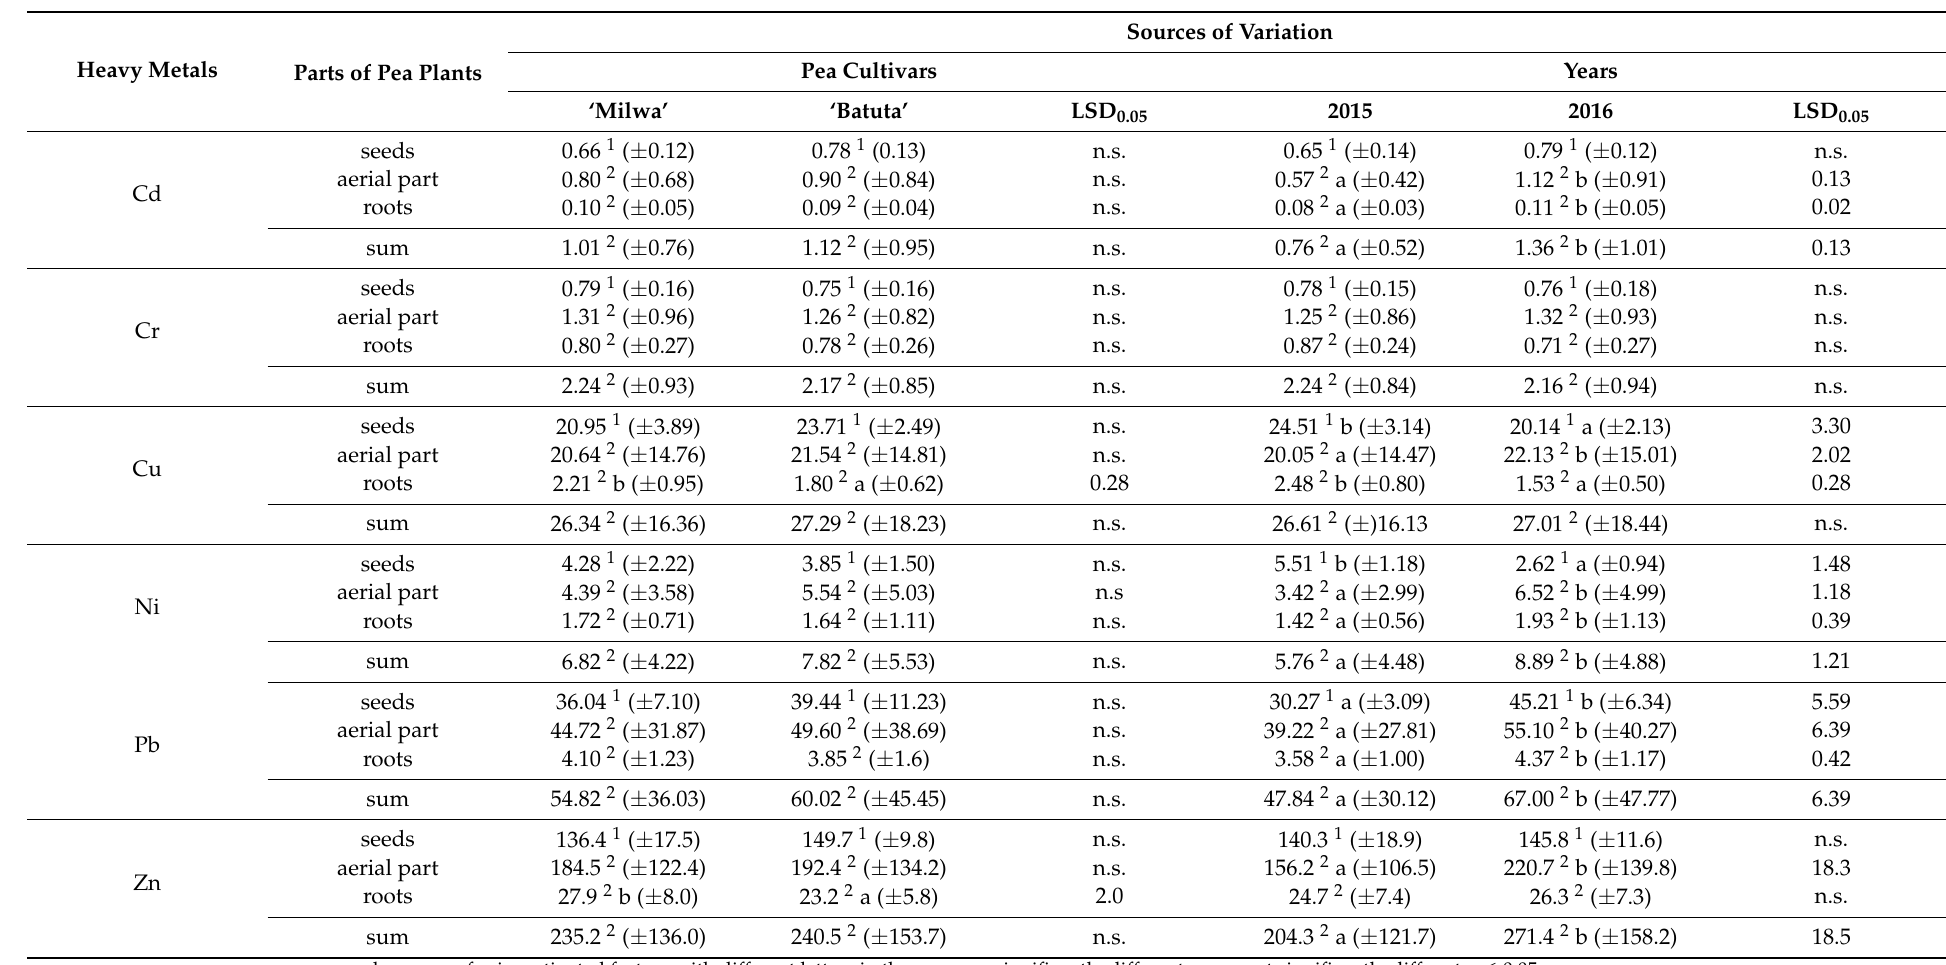
Table 6. HM up by pea plants, g · ha − 1 ( 1 mean values in maturity ± SD of two successive years or two cultivars, respectively, and with three repetitions each; 2 mean values ± SD of six growth stages, two successive years or two cultivars, respectively, and with three repetitions